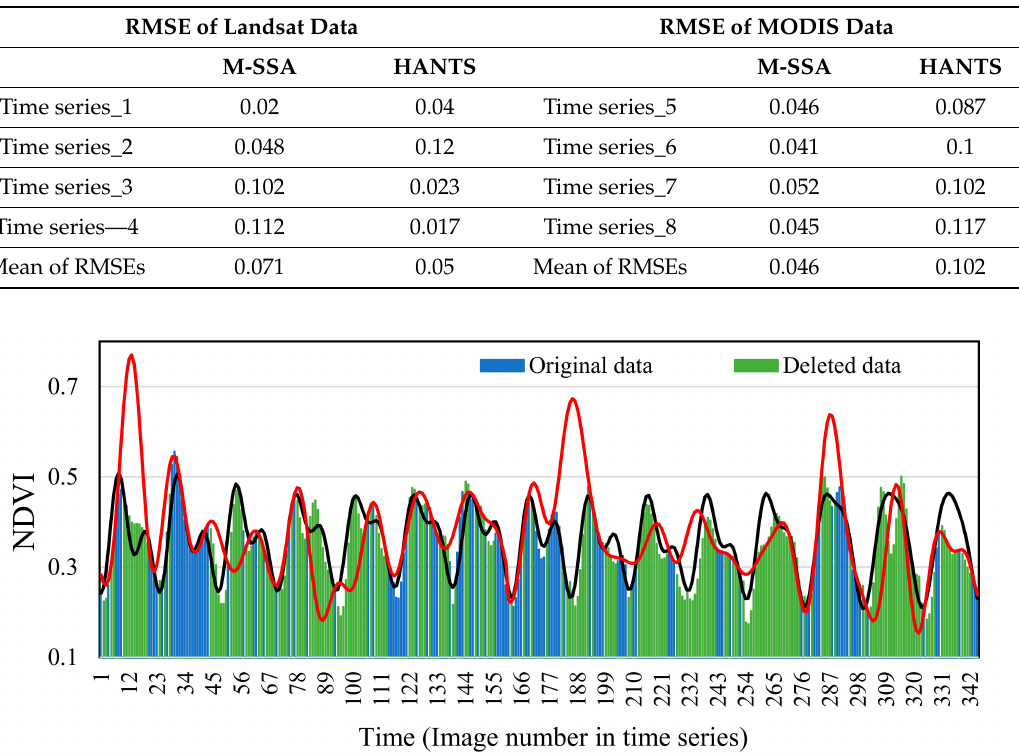
Figure 20. Original MODIS NDVI time series along with deleted data and reconstruction using HANTS (red line) and M-SSA (black line)